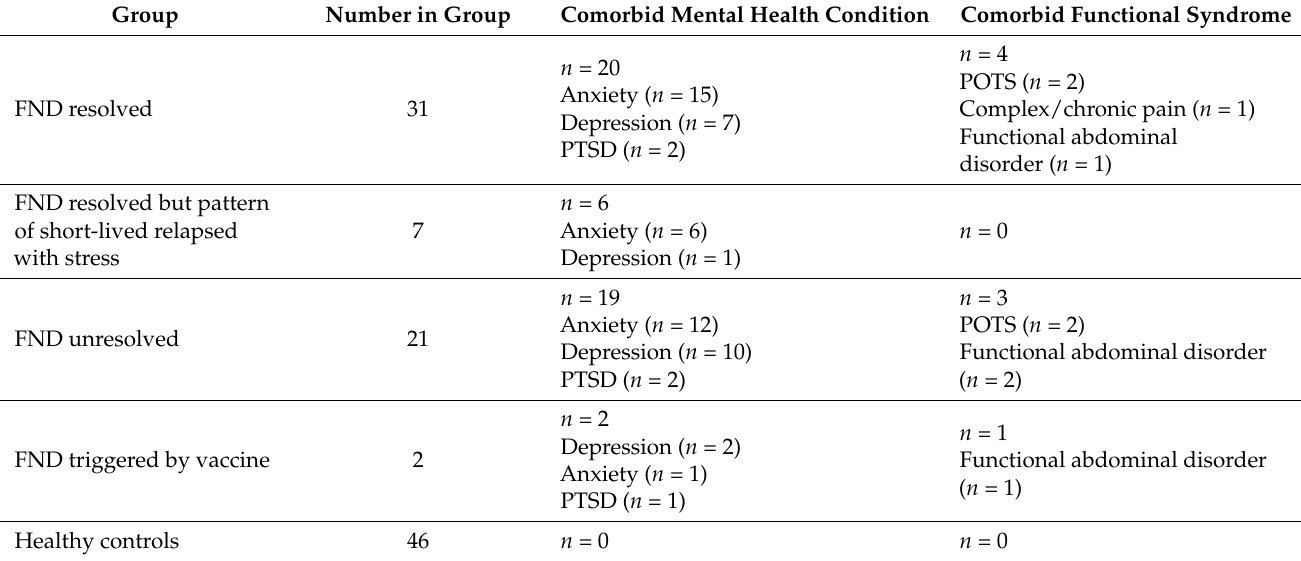
Clinical status of young people in the FND group at time of vaccination (or vaccination